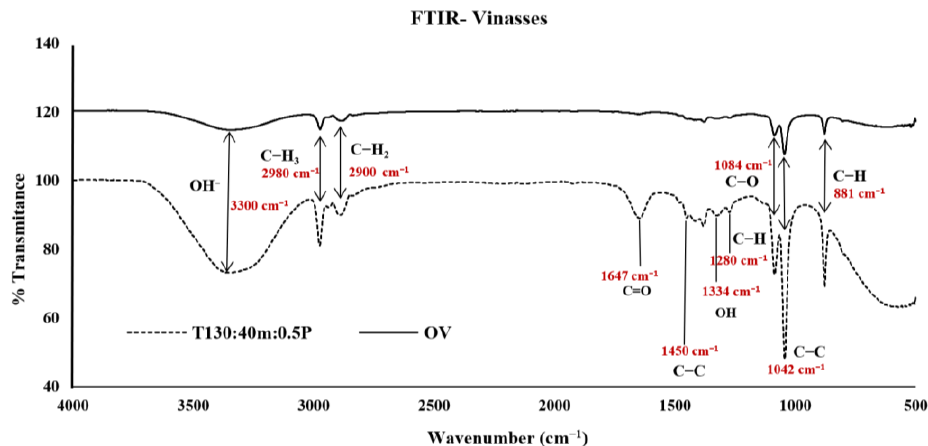
Figure 3. FTIR spectrum of original vinasse (OV) and treatment T130:40m:0.5P.